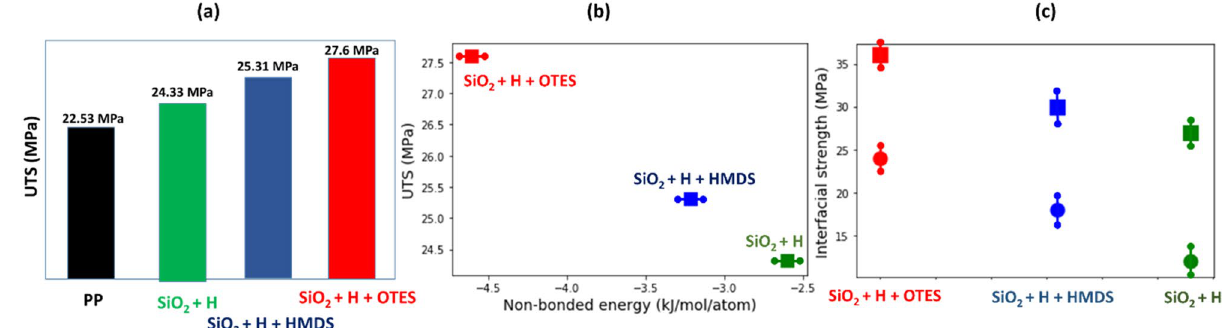
Figure 6. ( a ) The UTS of PP matrix (black) as compared with the PP composite containing the silica nanoparticles passivated by hydrogen atoms (green) and in addition functionalized with HMDS (blue) or OTES (red) molecules. ( b ) The UTS vs. non-bonded interaction interphase energy for the PP composites with silica nanoparticles passivated by hydrogen atoms (green squares) and in addition functionalized with HMDS (blue squares) or OTES (red squares). ( c ) Interfacial strength of PP/silica calculated for tensile (squares) and shear (circles) loading modes 66 . A planar silica surface is passivated by hydrogen atoms (green) and in addition functionalized with HMDS (blue) or OTES (red) molecules. Error bars are indicated for the non-bonded interaction interphase energy and interfacial strength in ( b , c